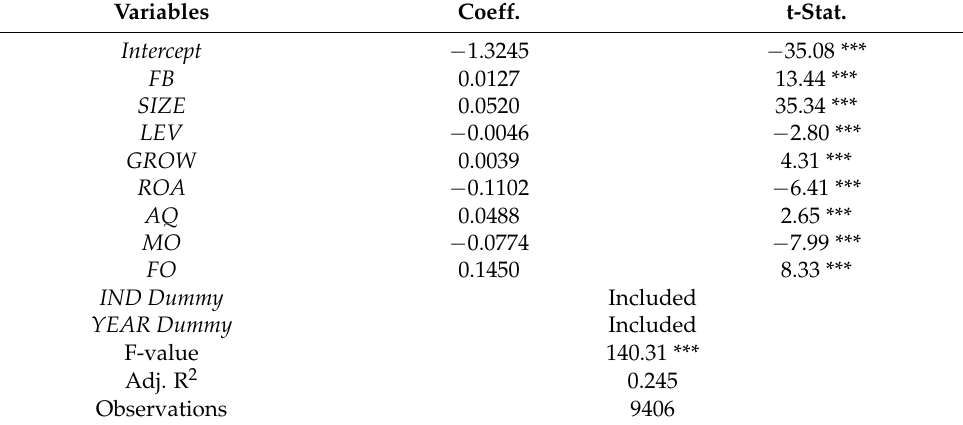
Table 4. The regression result of